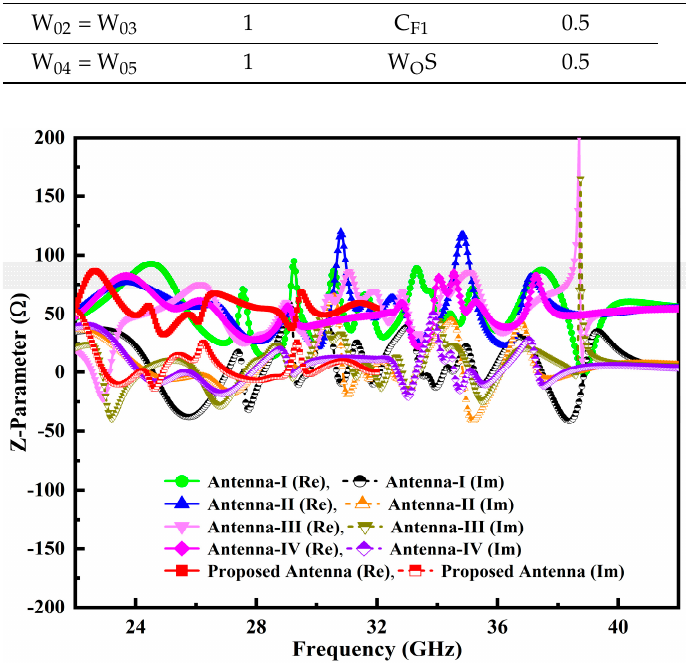
Figure 3. Z-parameter performance across the operable frequency span of the developed antenna prototypes.